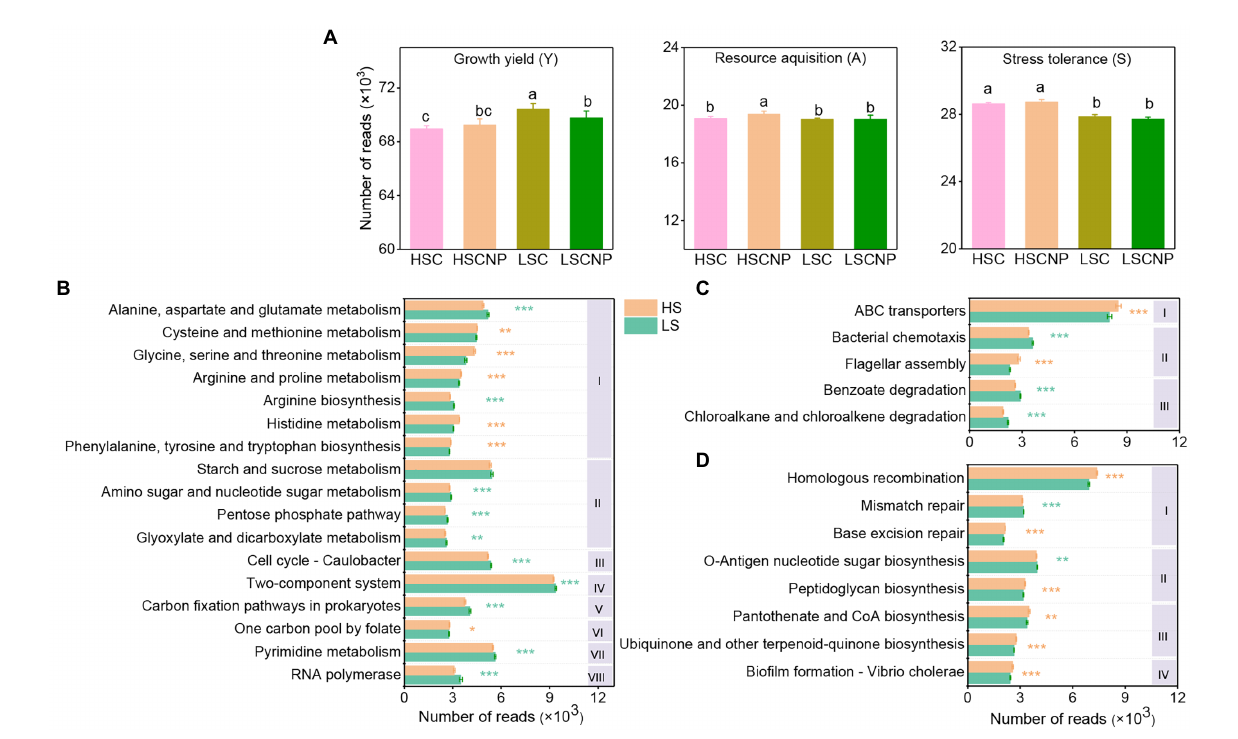
FIGURE 3 The reads numbers of functions related to the growth yield (Y-strategy), resource acquisition (A-strategy), and stress tolerance (S-strategy) according to KEGG annotations (A) . Specific KEGG functional categories assigned to the Y-strategy (B) , A-strategy (C) , and S-strategy (D) . The Roman numerals I, II, III, IV, V, VI, VII, and VII in subpanel (B) represent amino acid metabolism, carbohydrate metabolism, cell growth and death, signal transduction, energy metabolism, metabolism of cofactors and vitamins, nucleotide metabolism and transcription at the KEGG level 2, respectively. The Roman numerals I, II, and III in subpanel (C) represent membrane transport, cell motility and xenobiotics biodegradation and metabolism at the KEGG level 2, respectively. The Roman numerals I, II, III, and IV in subpanel (D) represent replication and repair, glycan biosynthesis and metabolism, metabolism of cofactors and vitamins and cellular community – prokaryotes, respectively. Orange asterisks indicate a higher abundance of functions in high-salinity soil, whereas green asterisks indicate a higher abundance of functions in low-salinity soil. Different letters indicate significant differences ( p <